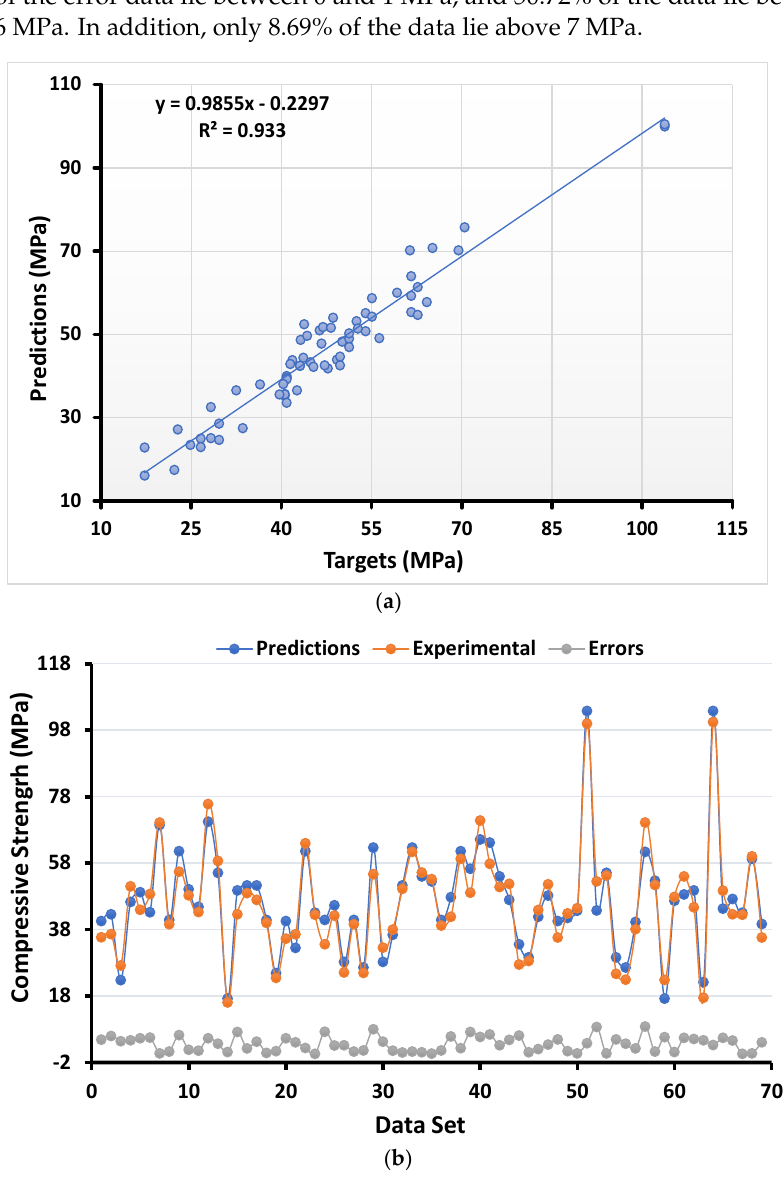
Figure 3. Numerical analyses representing the relationship between the predicted variables and targeted variables ( a ) along with their error distribution ( b ) for compressive strength using DT.